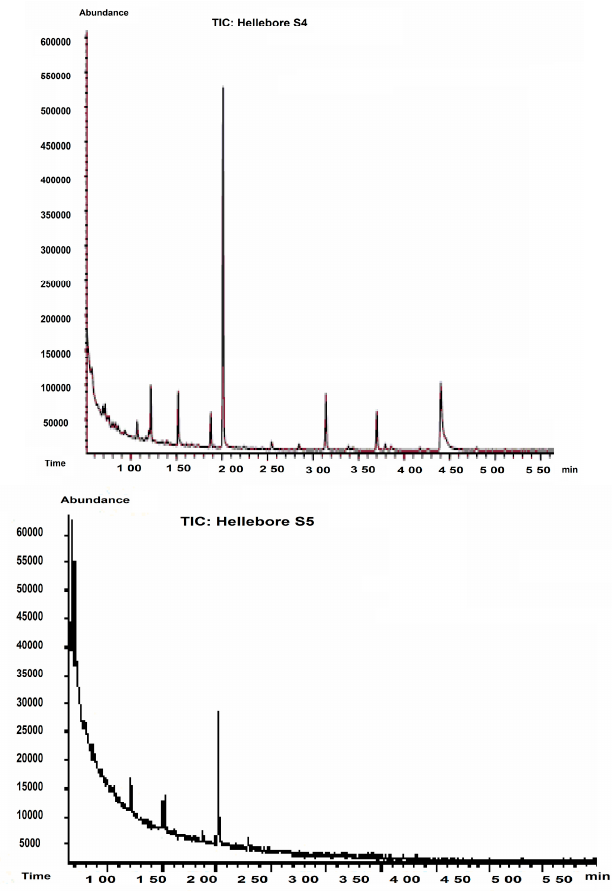
Figure 1. GC-MS chromatogram for S 1 –S 5 hellebore extract.